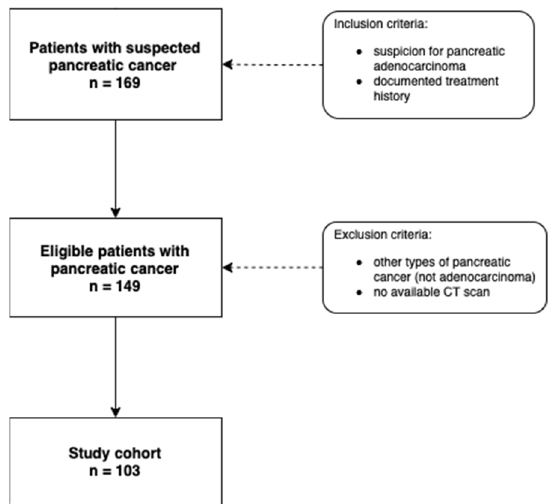
Figure 1. Flowchart depicting the inclusion and exclusion criteria for this study. CT = computed tomography, n = number.